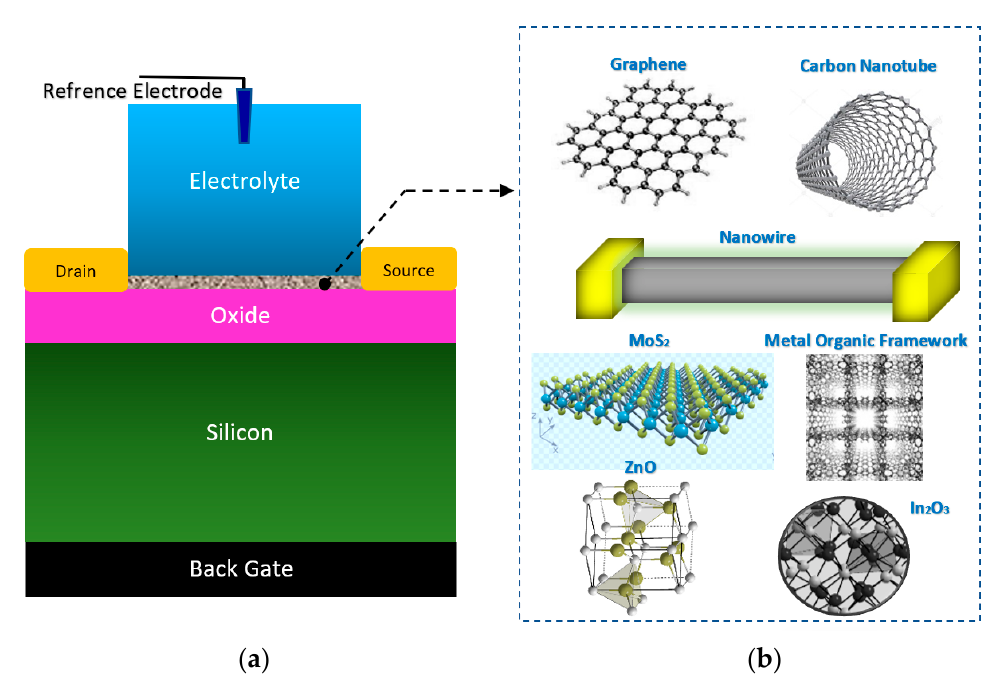
Figure 4. The general form of electrolyte and back gated structures of FETs, which have been used for the sensing elements in Chem/BioFET: This nanomaterial-based structure has been widely used for cell, DNA, enzymatic reaction and chemical sensing; ( a ) sensor structure; ( b ) the most frequent nanomaterials used as sensing element and main conductive channel.